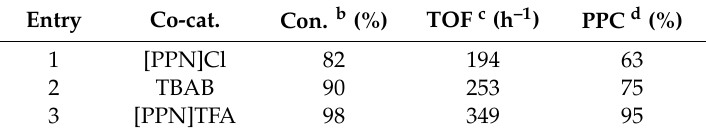
Table 5. (Salen- 4 )[Co(III)TFA] 2 catalyzed PO / CO 2 copolymerization under di ff erent cocatalyst a . Entry